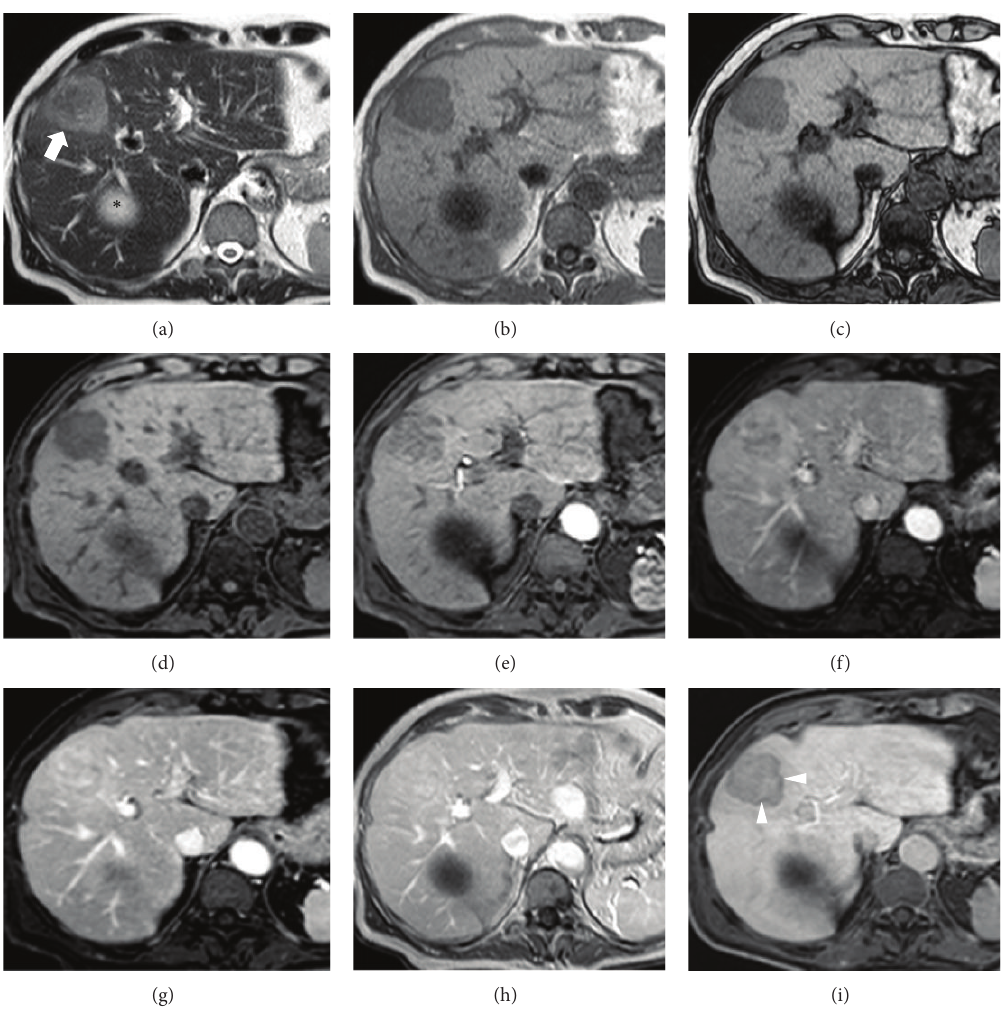
Figure 11: Peripheral CCC. (a) Axial T2w image. In S IV slightly heterogeneous hyperintense lobulated lesion (arrow); cyst (asterisk). (b-c) T1w in- and out-phased images. The lesion appears hypointense. (d–h) In dynamic evaluation after GD-BOPTA administration the nodule appears slightly heterogeneous hypervascular in arterial phase (e) with progressive enhancement in portal and equilibrium phases. After 5 󸀠 (h) note persistent enhancement and peripheral wash out. (i) Epatobiliary phase image after 1h. The lesion appears hypointense, showing central pooling and more evident peripheral wash out